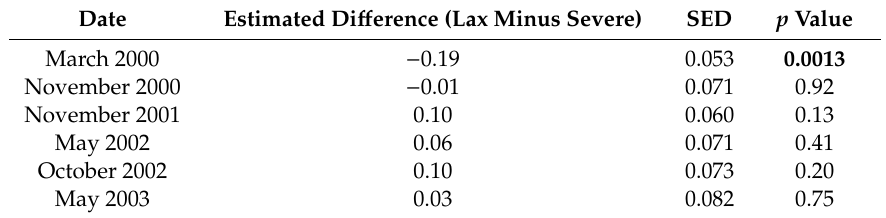
Table 2. Estimated di ff erence in the square root of crown density in Experiment 1 (Burraja) between severe and lax defoliation (lax minus severe). In the fitted models, this di ff erence is the same at all target densities. The standard error of di ff erence (SED) and p values use the residual mean square of the saturated cutting level by relative target crown density factorial, as presented in Table 2. This provides 27 residual degrees of freedom, except for the November 2000 sampling that had 25 residual degrees of freedom.